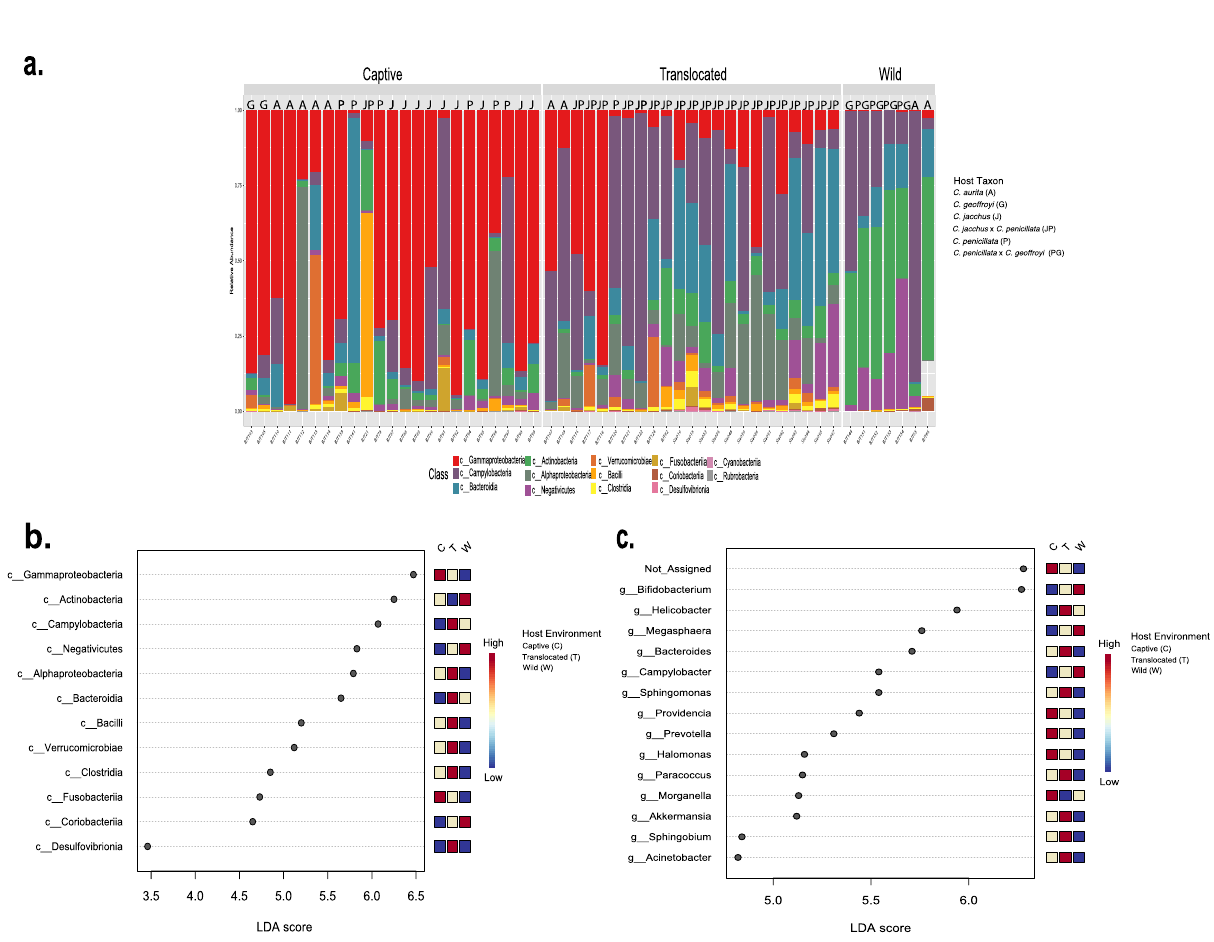
Figure 3. ( a ) Relative class level bacterial abundance (lower legend) by host environment (Captive, Translocated, and Wild) and taxon (see right-side legend). ( b ) LefSe analysis of bacterial class abundance categorized by host environment. ( c ) LefSe analysis of bacterial genus abundance categorized by host environment. The corresponding legends for plots ( b ) and ( c ) are to the right of both